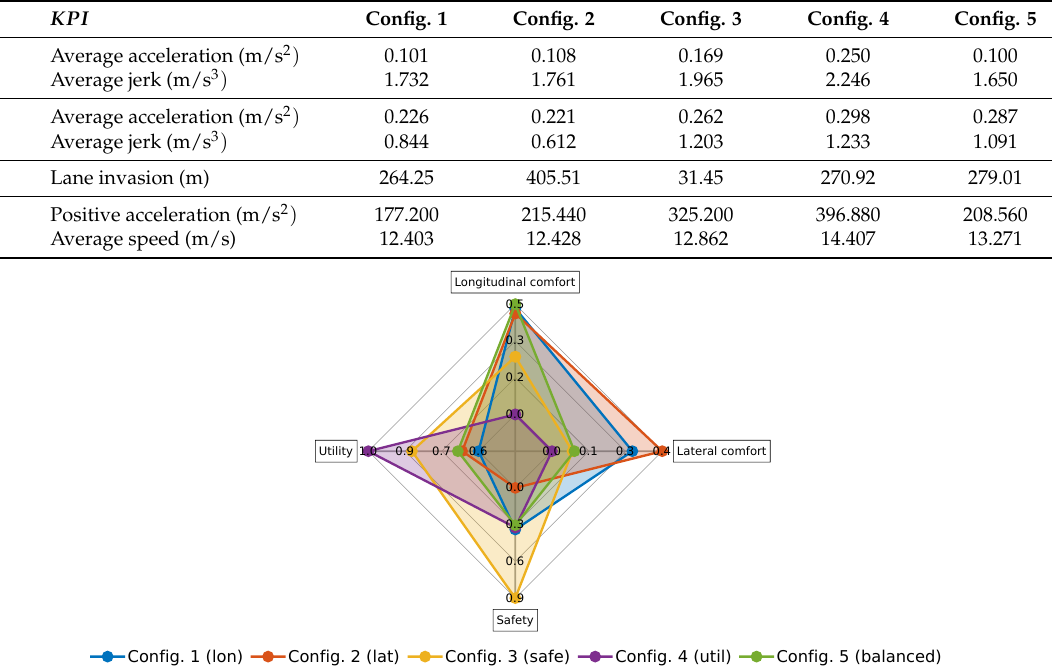
Figure 24. Radar plot of the compared categories in the real vehicle